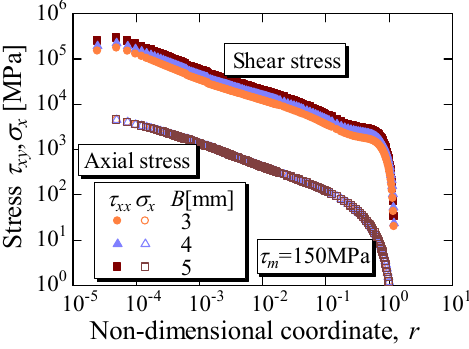
Figure 14. Shear and tensile stress distributions for various specimen widths under constant average shear stress condition of τ m = 150